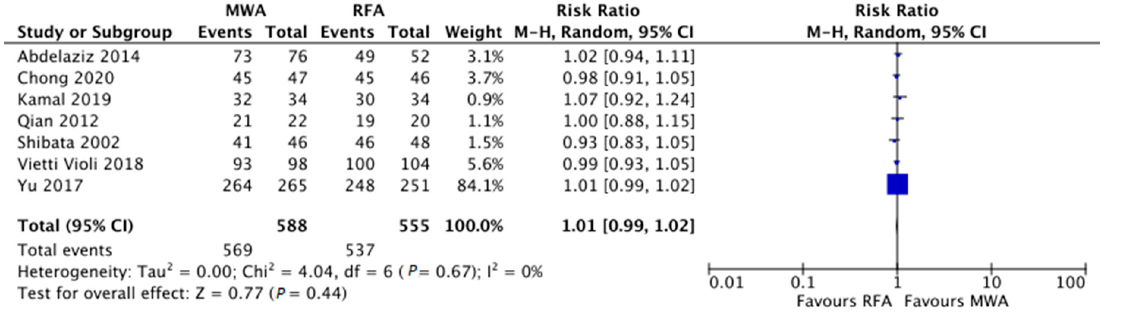
Figure 2. Risk ratio concerning the comparison between microwave and radiofrequency ablation in terms of complete response was 1.01 (95% confidence interval 0.99–1.02), with no evidence of heterogeneity (I 2 = 0%).